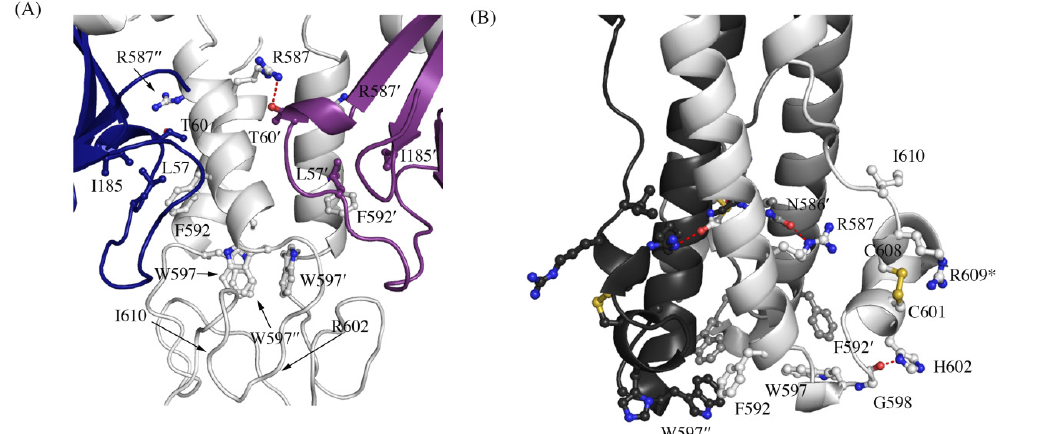
Figure 3. Interaction of residues in the chain reversal region in (A) the prefusion and (B) the post fusion EBOV-May GP SUDV-Bon GP 1,2